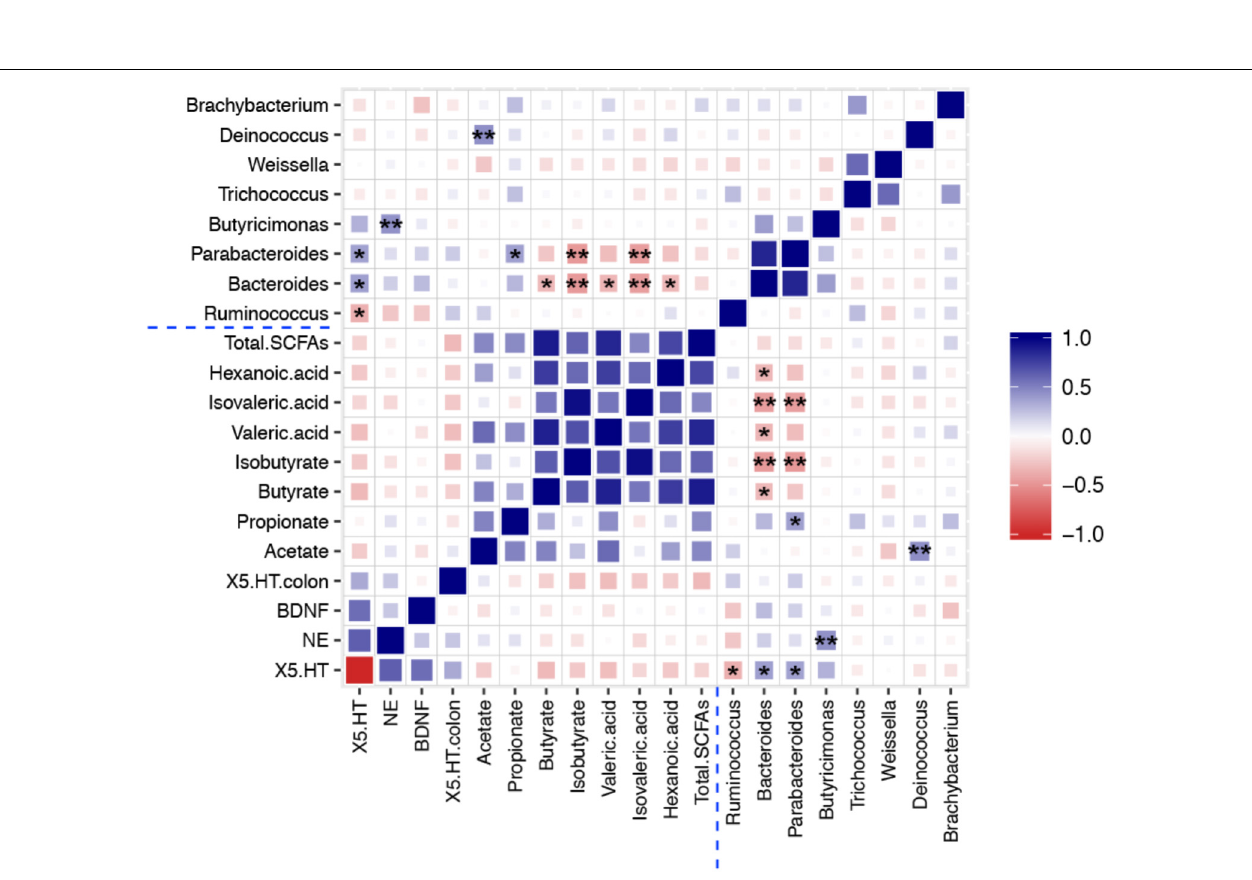
Frontiers in Pharmacology |